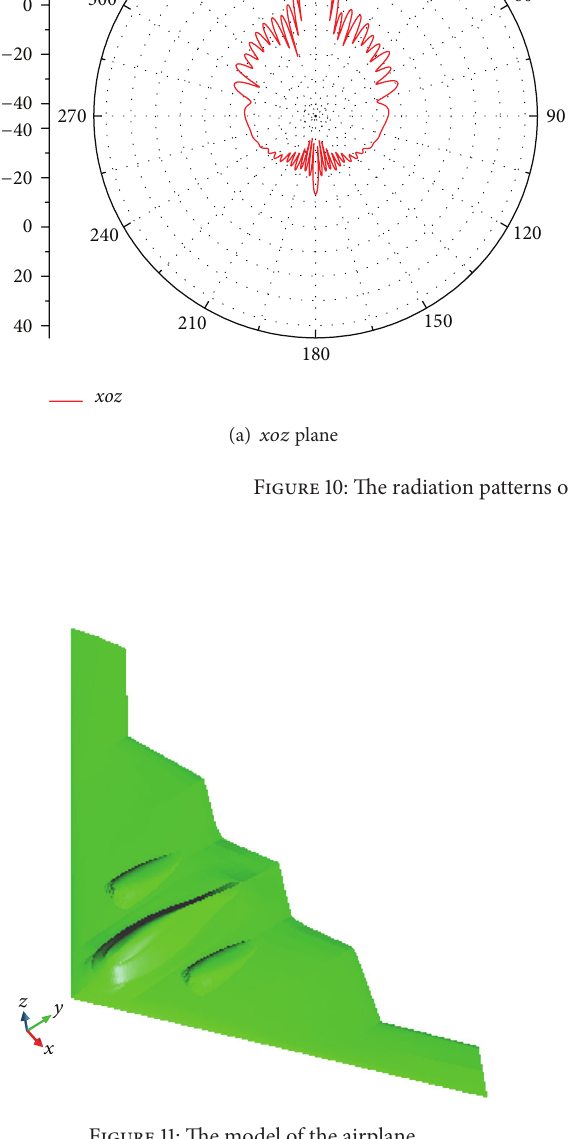
Figure 11: The model of the